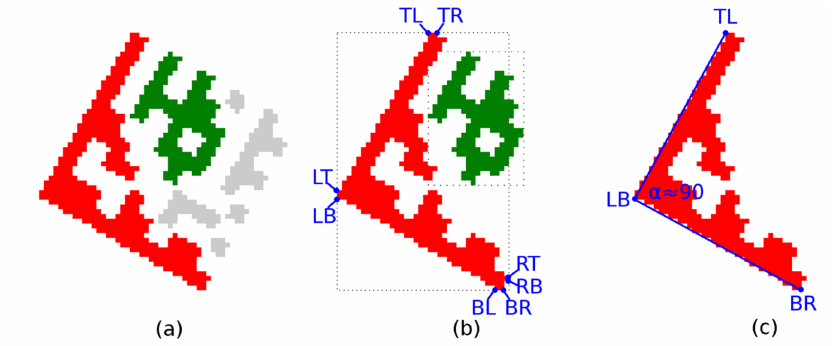
Figure 9. Data Matrix Finder Pattern candidates. ( a ) suppression of unfitting regions; ( b ) 8 boundary points of region; ( c ) 3 vertices of a right